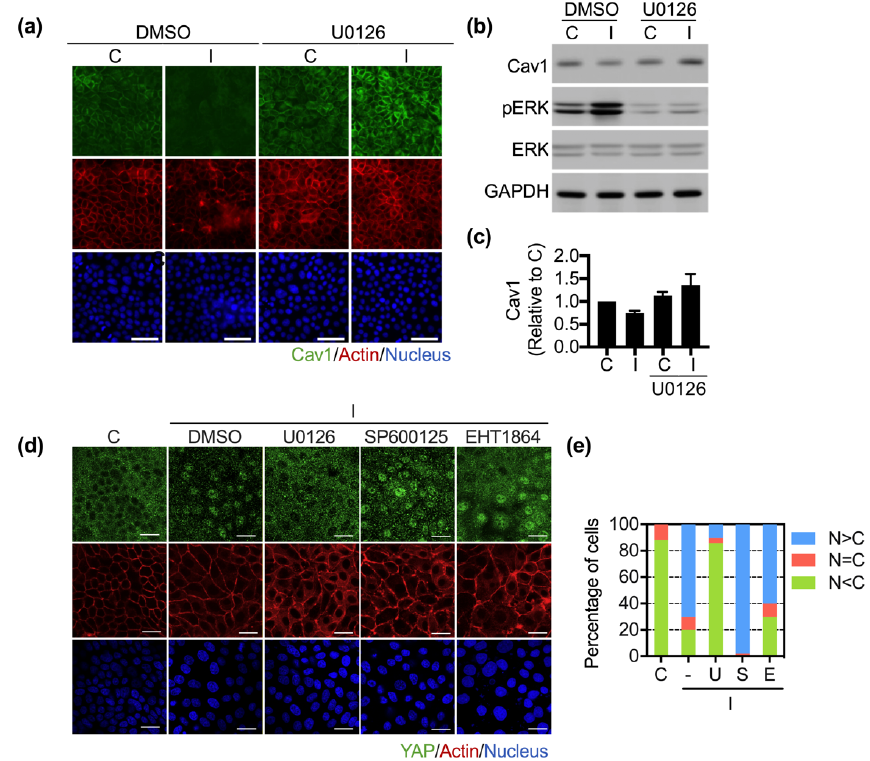
Figure 4. MEK is required for Ha-Ras V12 -induced YAP nuclear translocation and Cav1 downregula- tion. MK4 cells at the overconfluent stage were pre-treated with or without U0126 (20 µM,